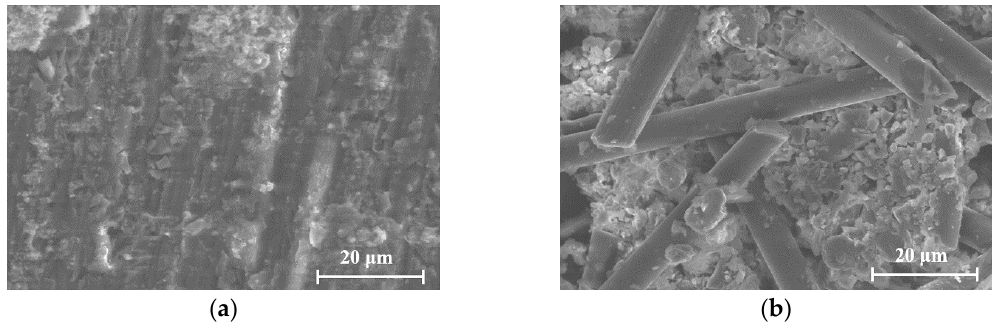
Figure 10. Scanning electron microscopy results of the CFRP after EC test for 310 days: ( a ) B-EB-20 specimens; ( b ) B-IB-100 specimens.